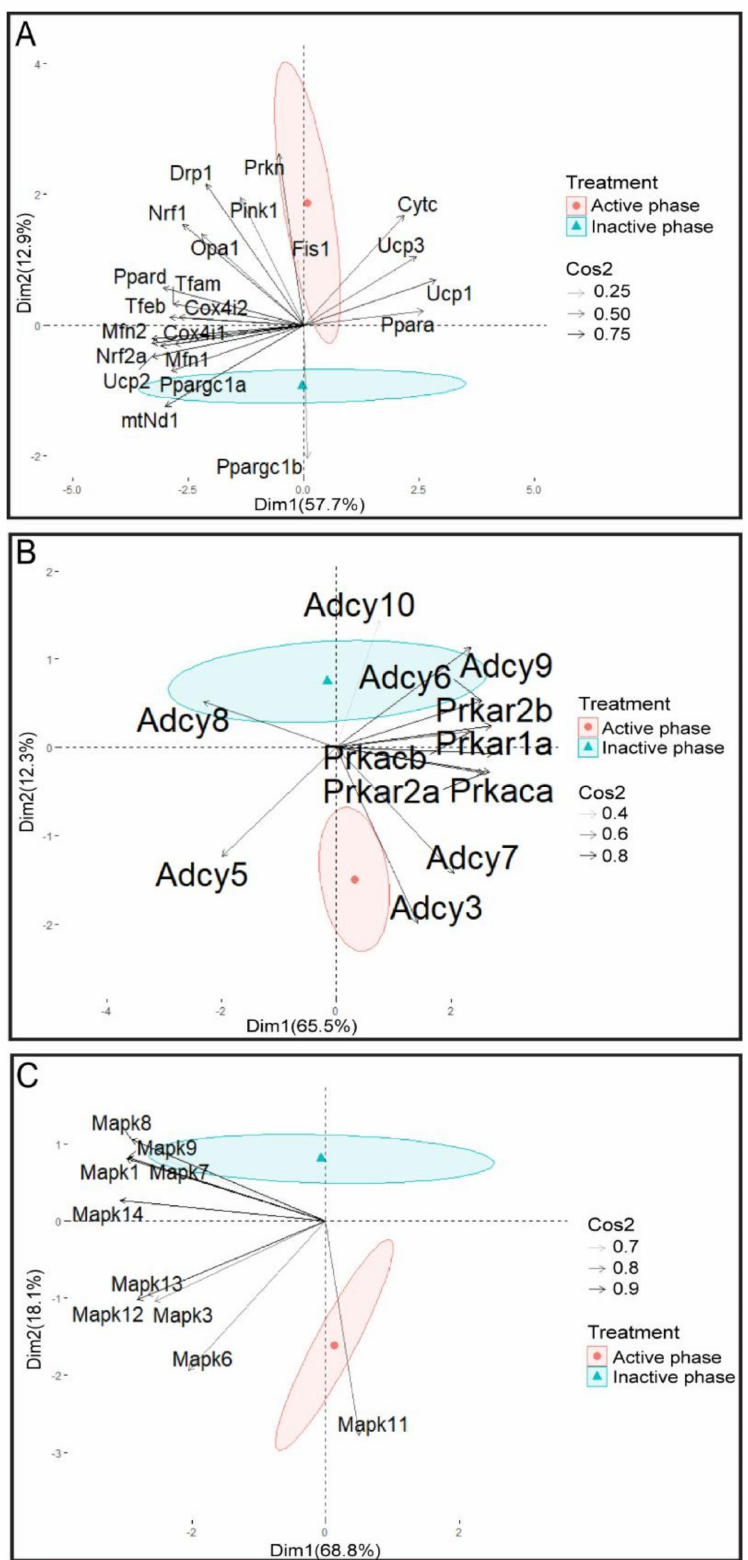
Figure 12. PCA of mitochondrial dynamics ( A ), cAMP signaling pathway ( B ), MAPK signaling pathway, ( C ) and gene expression on active/inactive phase; Dim1 and Dim2 represent the first two PCs and % of the retained variation. Cos2 estimates the qualitative representation of